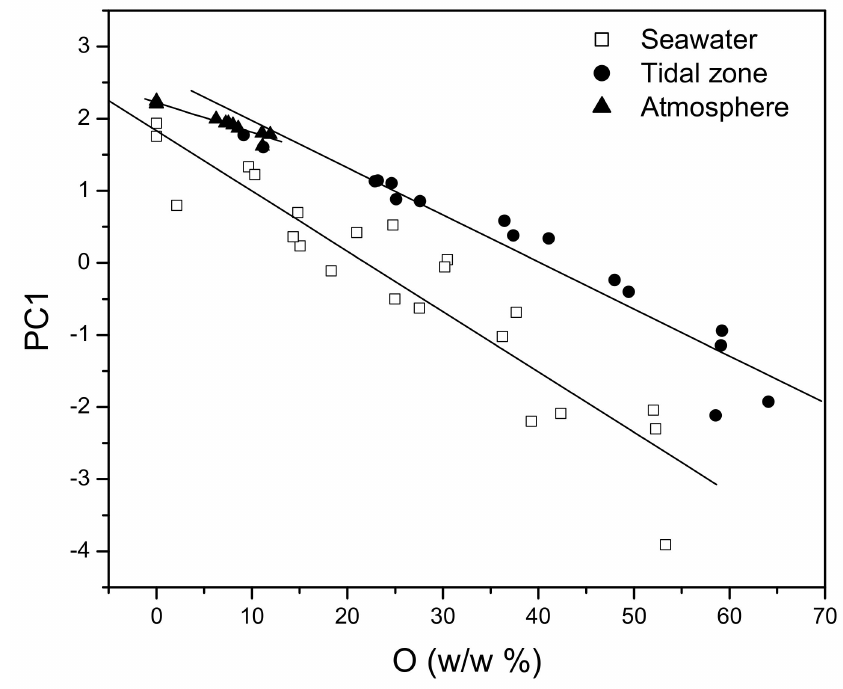
Figure 13. The change in PC1 values in the function of oxygen